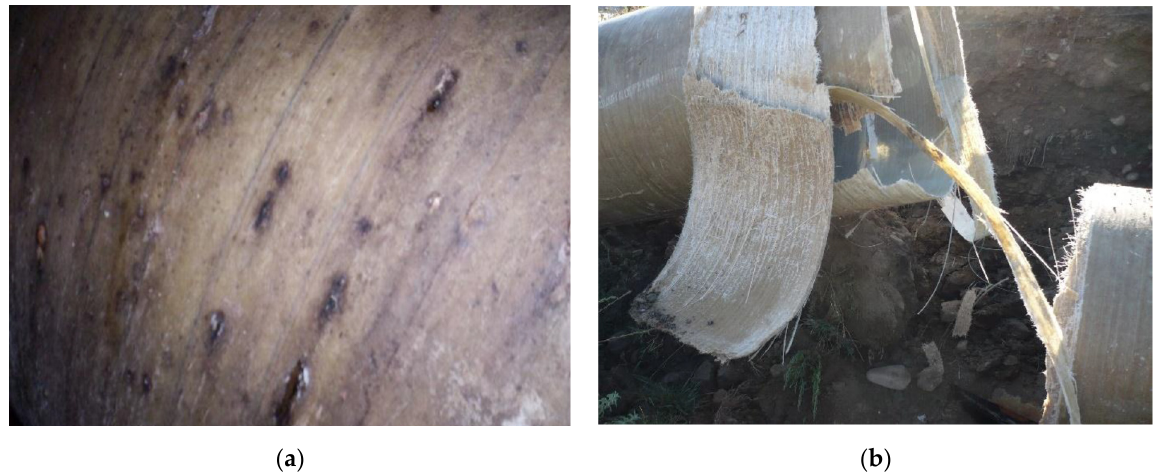
Figure 1. Damage to the glass-reinforced plastic pipeline in ( a ) basic soil and ( b ) acidic soil.